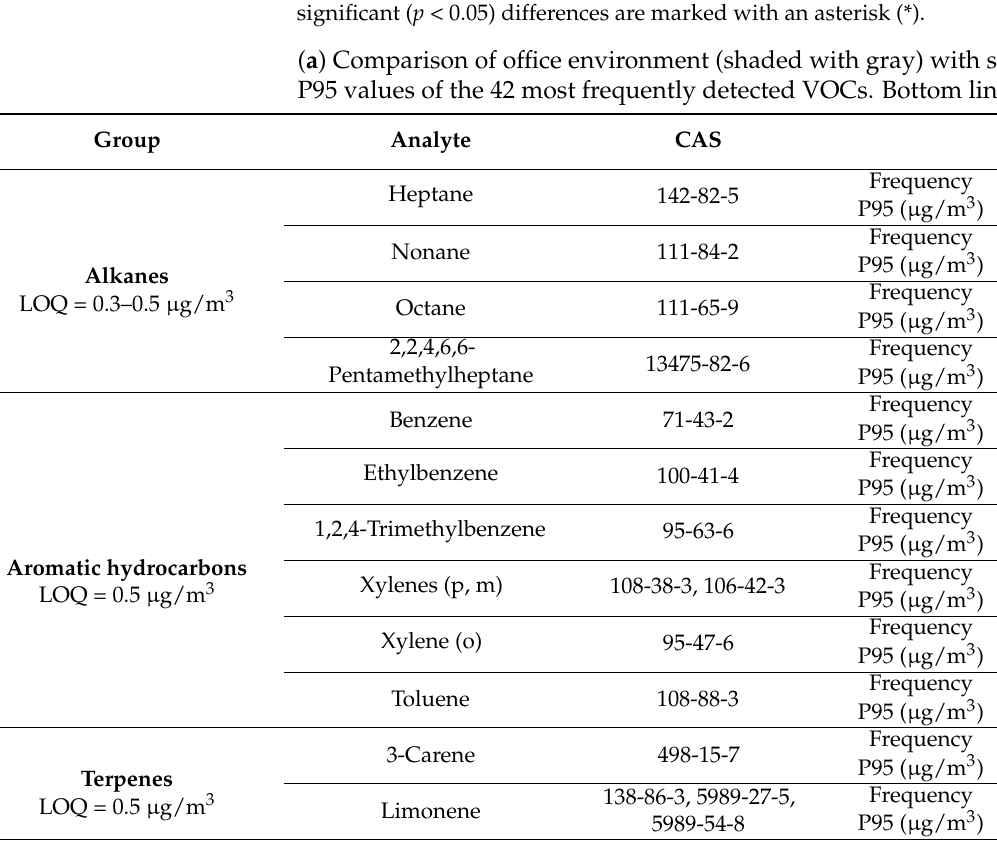
Table 3. Comparison of office environment with school, kindergarten, and healthcare office environments with regard to VOCs ( a ) and formaldehyde ( b ). Statistically significant ( p < 0.05) differences are marked with an asterisk